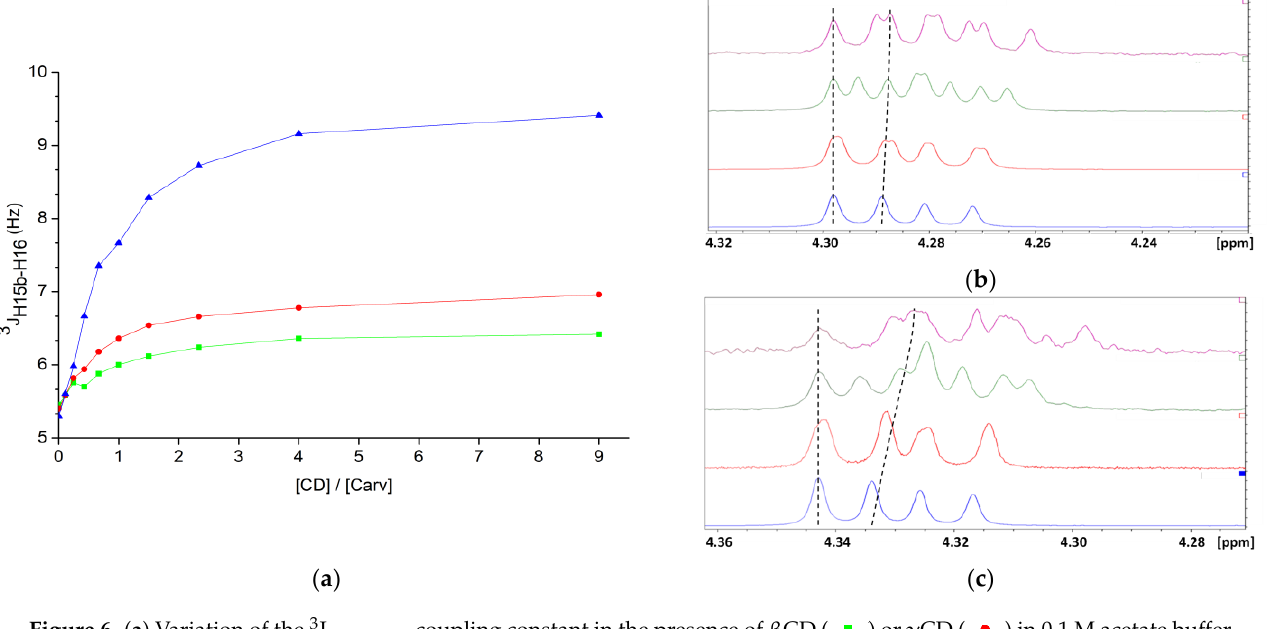
Figure 6. ( a ) Variation of the 3 J H15b,H16 coupling constant in the presence of βCD ( ) or γCD ( ) in 0.1 M acetate buffer or DIMEB ( ) in 13 mM HCl, at different molar fractions. ( b ) Stacking of partial 1 H NMR (600 MHz, 298 K) spectra scaled on H15b of carvedilol, corresponding to experiments with γCD and ( c ) with DIMEB at the following CD molar fractions: 0.0 ( ), 0.3 ( ), 0.6 ( ), 0.9 ( ). The gap between the dotted lines corresponds to the 3 J H15b-H16 .